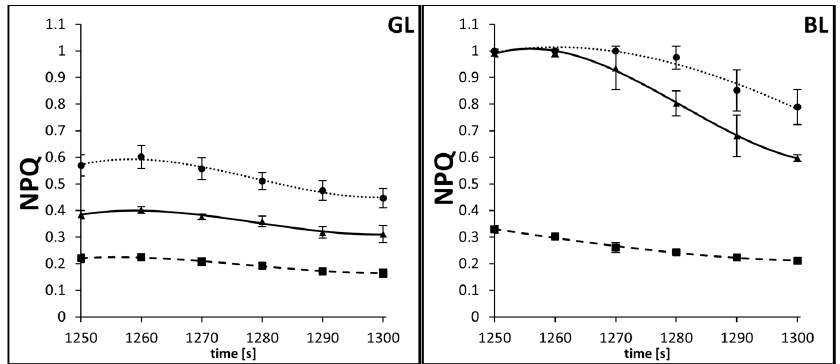
Figure 3. Dynamic changes of fast relaxation of non-photochemical quenching, NPQ, in leaves of tomato plants ( Solanum lycopersicum L. cv. Malinowy Ozarowski) grown under different LED light conditions (see Material and Methods for details). 10 mm diameter leaf discs were infiltrated with 10 mM ascorbic acid (AsA) or 5 mM dithiothreitol (DTT), or distilled water (C, control) for 30 min in the dark, followed by pre-illumination at 500 µmol m − 2 s − 1 of RGB light for next 30 min. The dynamics of the NPQ relaxation were determined in leaf samples immediately after actinic light turn off and derived from saturation pulses (5000 µmol m − 2 s − 1 , 0.8 s) applied every 10 s during the first 50 s of darkness. Each data point represents the average ± SD of six independent measurements ( n = 6). The cubic polynomial regression model was employed to fit the experimental data of fast (50 s) qE NPQ relaxation in the AsA-, DTT- or water-treated samples. Fitting was applied as